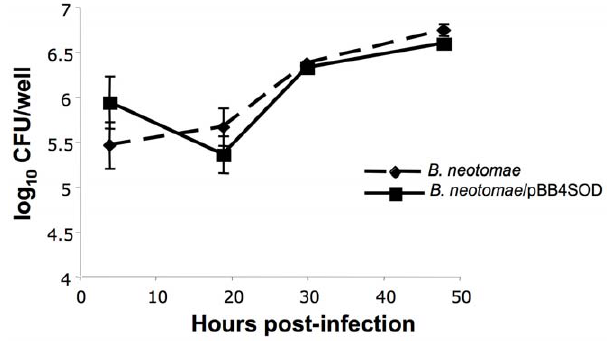
Figure 9. Intracellular survival and replication of B.neotomae and B.neotomae /pBB4 SOD in J774A.1 cells. Infection of J774A.1 cells was performed in triplicate as described in Materials and Methods, and for each time-point, results are shown as the mean 6 standard deviation of log 10 CFU per well. At each time-point there was no significant difference between the two groups ( P . 0.05).